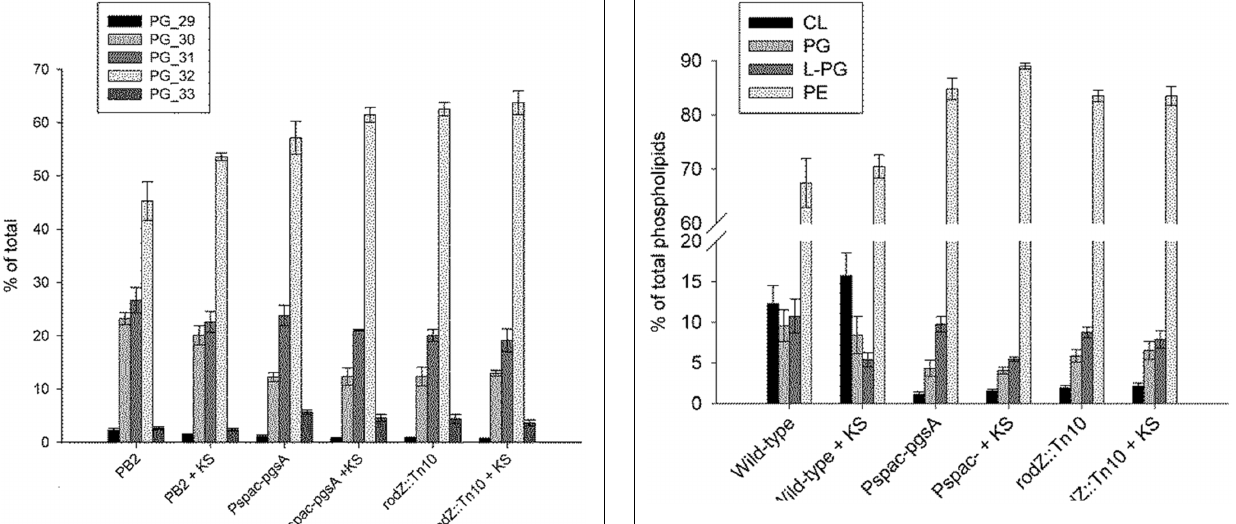
FIGURE 4 | Lowered cardiolipin (CL) and phosphatidylglycerol (PG) levels in the rodZ transposon and conditional pgsA mutant, and lowered lysyl-phosphatidylglycerol (L-PG) levels in the WT strain upon sorbic acid stress. The phospholipid composition was measured in exponentially growing cells of the WT (PB2), pgsA ::P spac-pgsA and rodZ ::mini-Tn 10 mutant strains 45 min after treatment with or without 5 mM